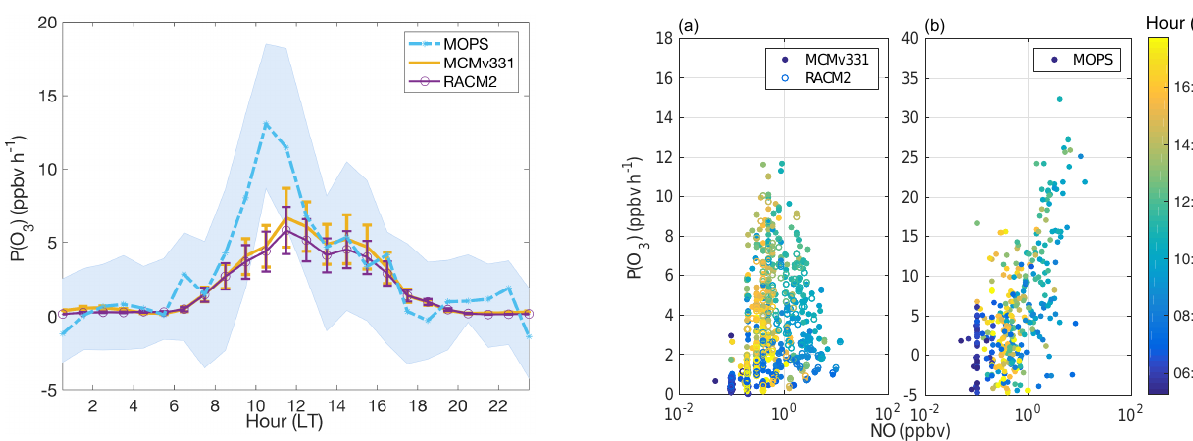
Figure 3. RACM2, MCMv331 (a) , and MOPS (b) 30min P(O 3 ) as a function of measured NO for all MOPS measurement days. Points are colored by hour of day from 06:00 to